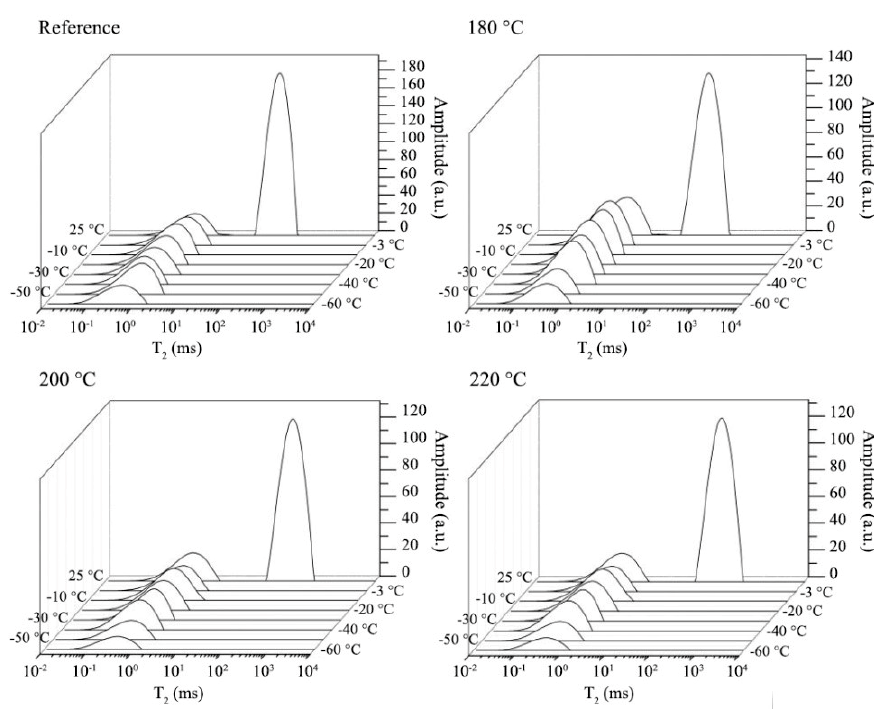
Figure 2. The T 2 distribution of Norway spruce at various temperatures.